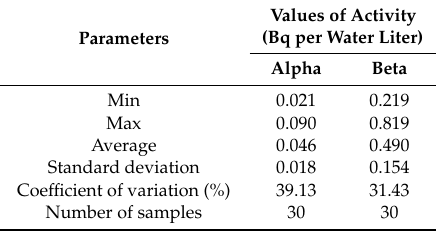
Table 5. Statistic of characterization of alpha and beta concentration in water.